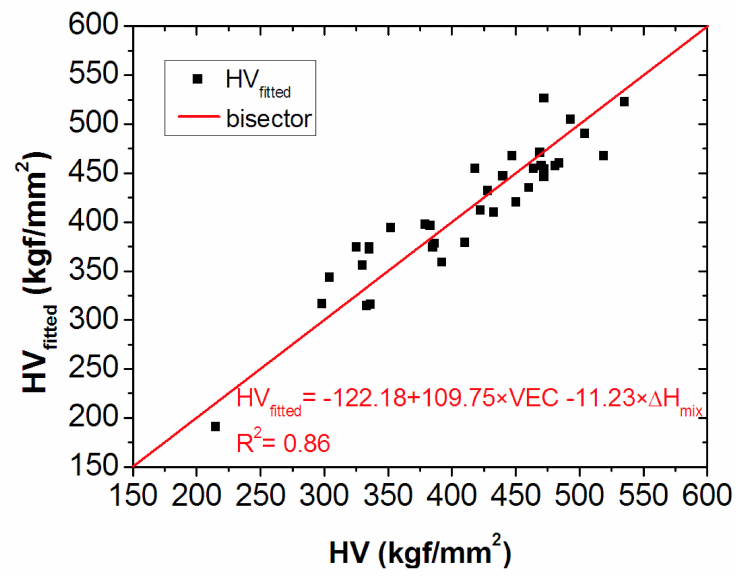
Figure 6. Relationship between the accepted and fitted values of HV , which line up around the first bisector.